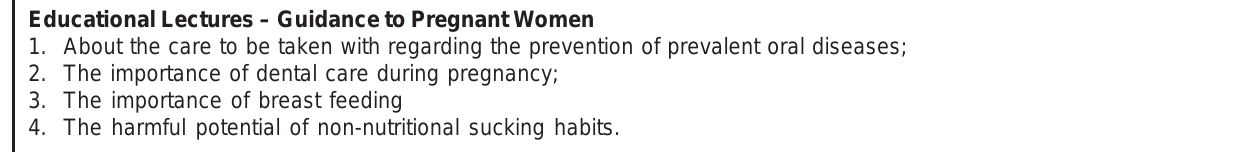
FIGURE 1- Attendance Protocol of the Preventive Program for Pregnant Mothers and Babies. Federal University of Piauí,